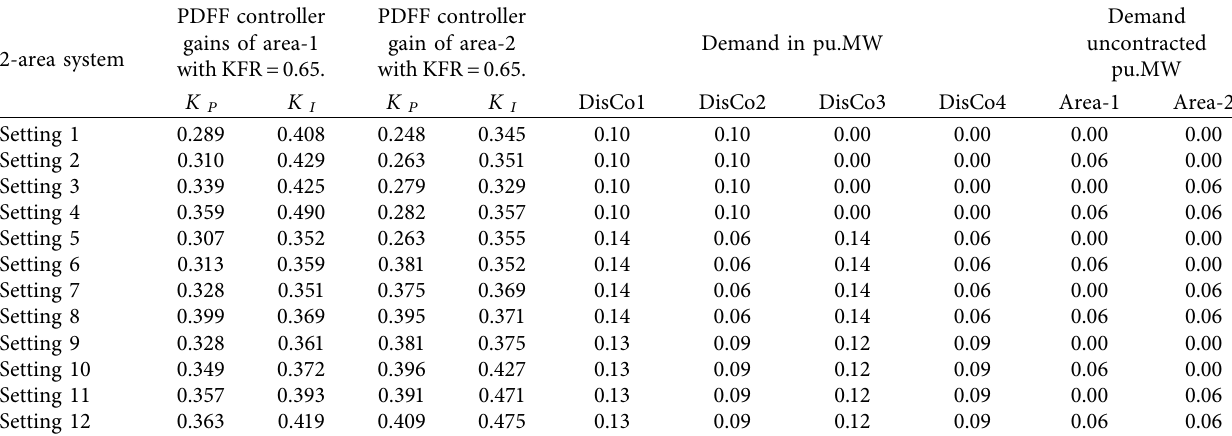
Table 2: Optimized PDFF controller gains for the power system under investigation.